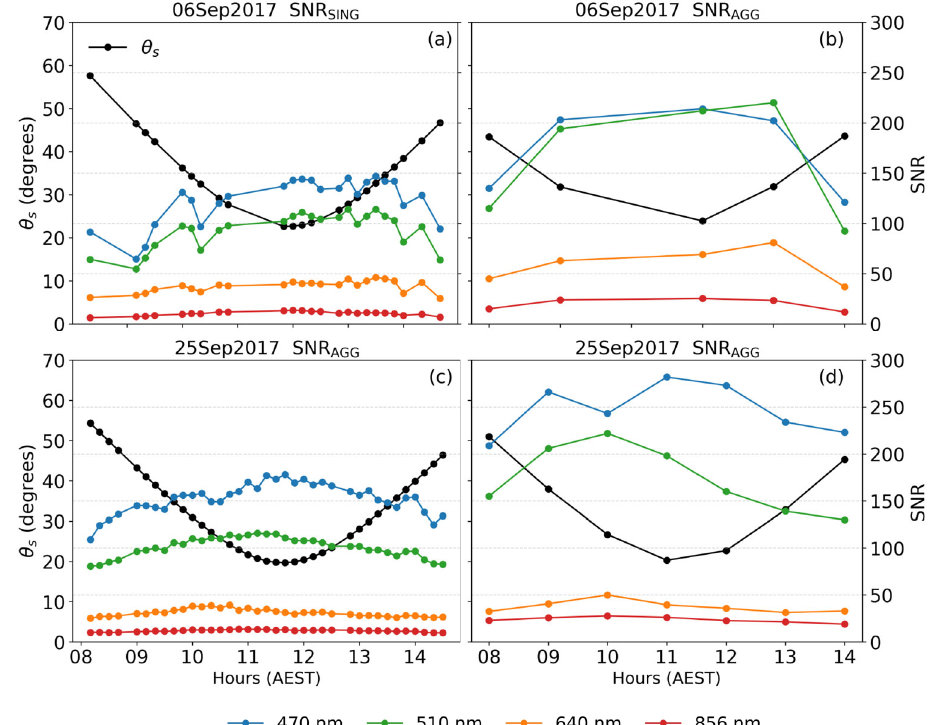
Figure 9. Time series of signal-to-noise ratios (SNR, right axis) computed for single ( SNR SING ) ( a , c ) and for aggregated ( SNR AGG ) observations ( b , d ) with associated θ s (left axis). The SNR is coded by band.